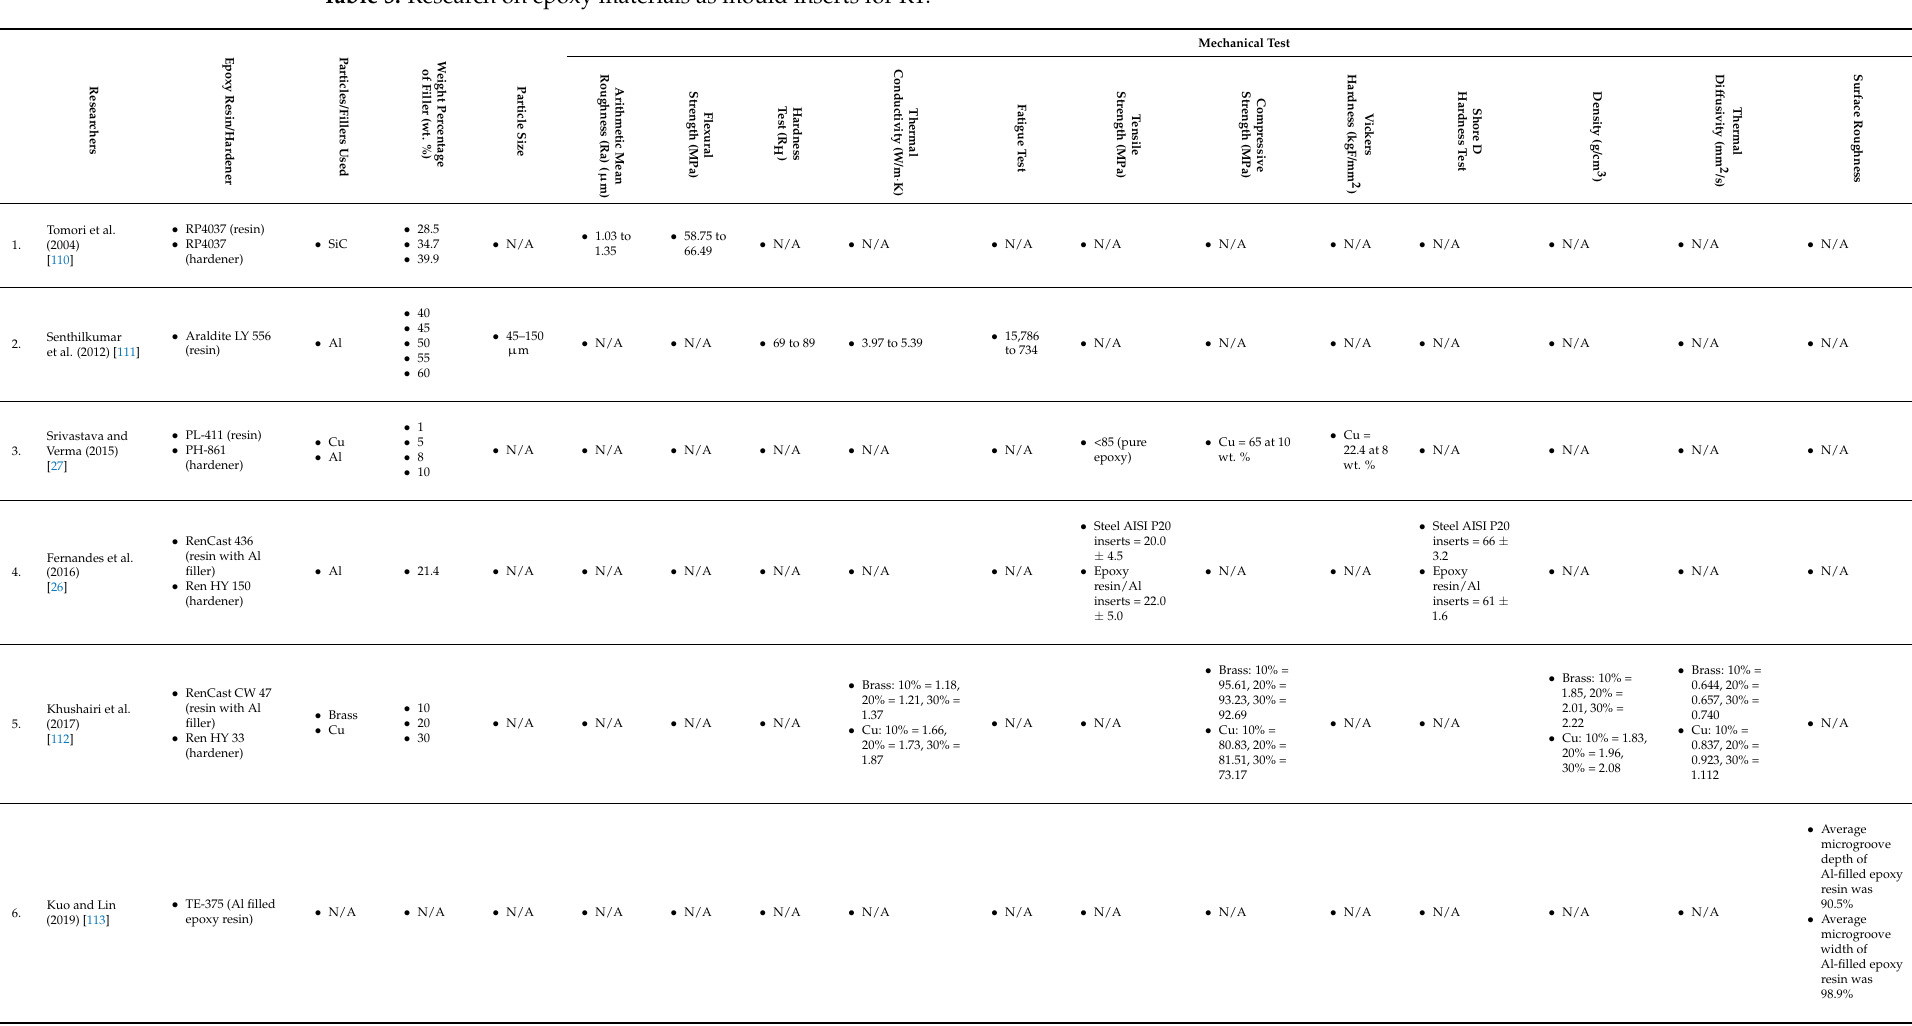
Table 5. Research on epoxy materials as mould inserts for